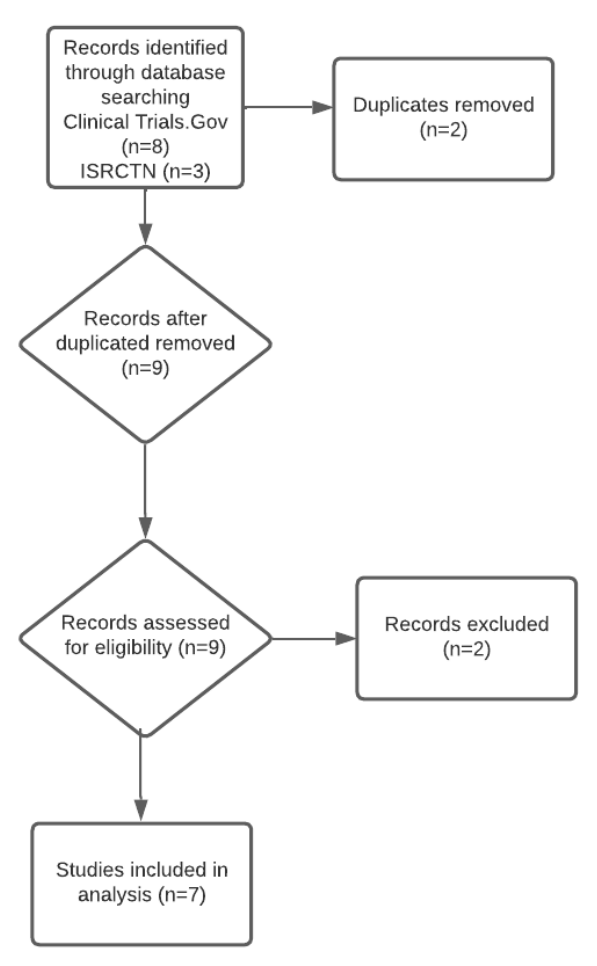
Figure 2. PRISMA flow diagram of retrieval of registered clinical Figure 2 . PRISMA flow diagram of retrieval of registered clinical trials .